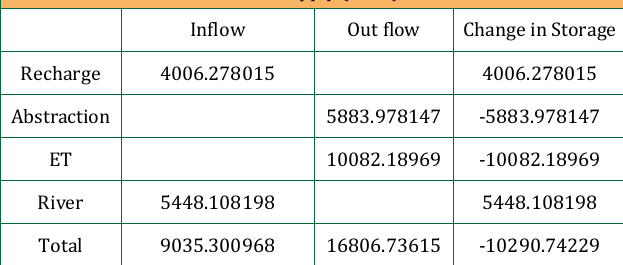
Table 9: Annual GW abstractions decreased 30% with increased the Canal Supply